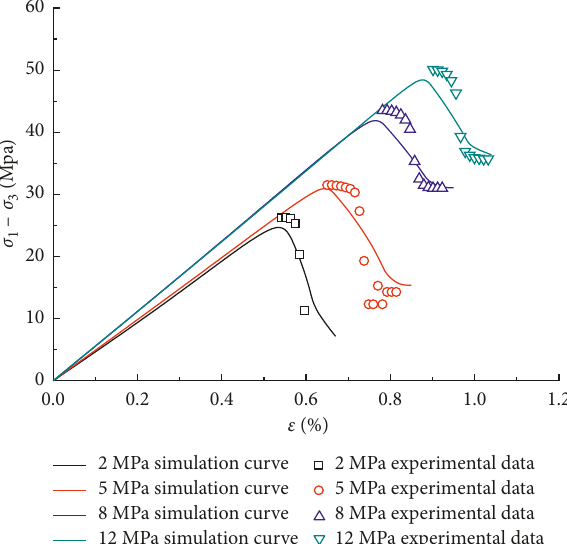
Figure 9: Comparison between Hawkesbury sandstone triaxial compression test data and numerical simulation